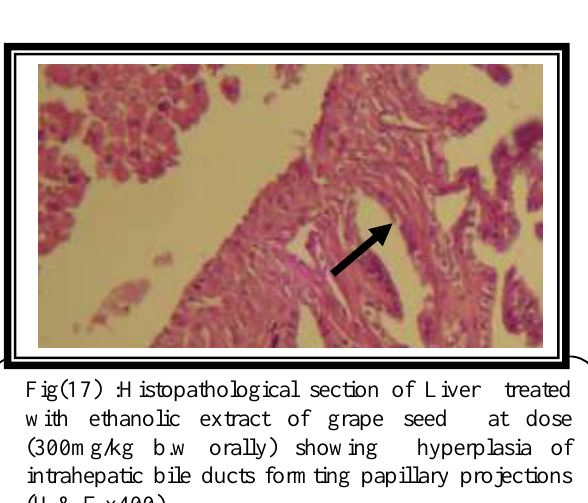
Fig(17) :Histopathological section of Liver treated with ethanolic extract of grape seed at dose (300mg/kg b.w orally) showing hyperplasia of intrahepatic bile ducts formting papillary projections (H & E x400).